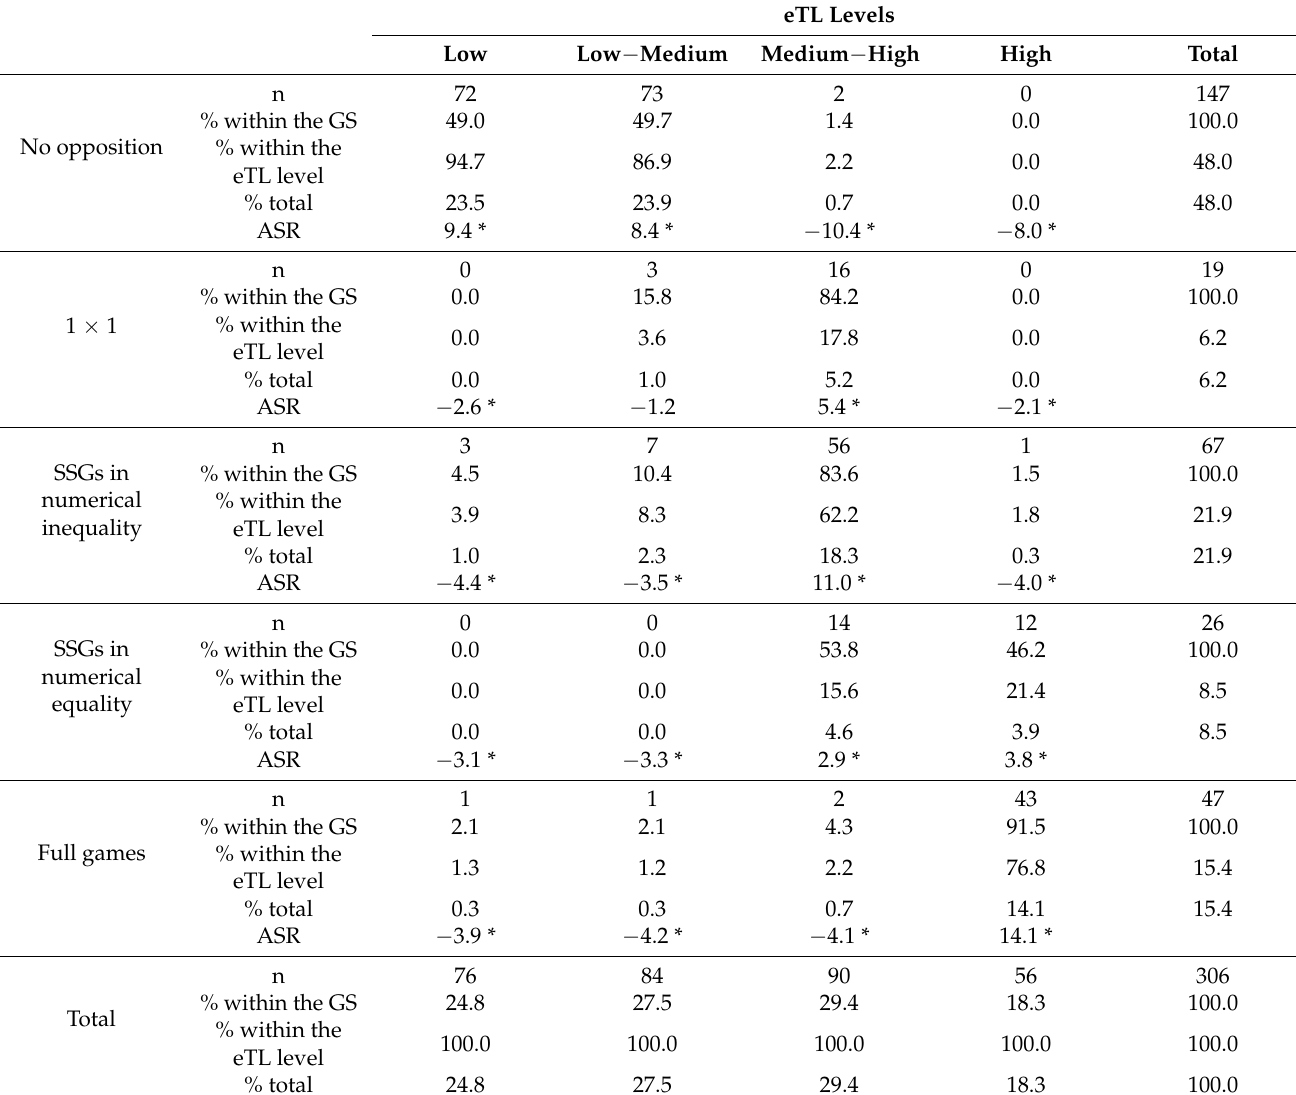
Table 2. Descriptive results and ASRs of the task-induced eTL, depending on the game situation.